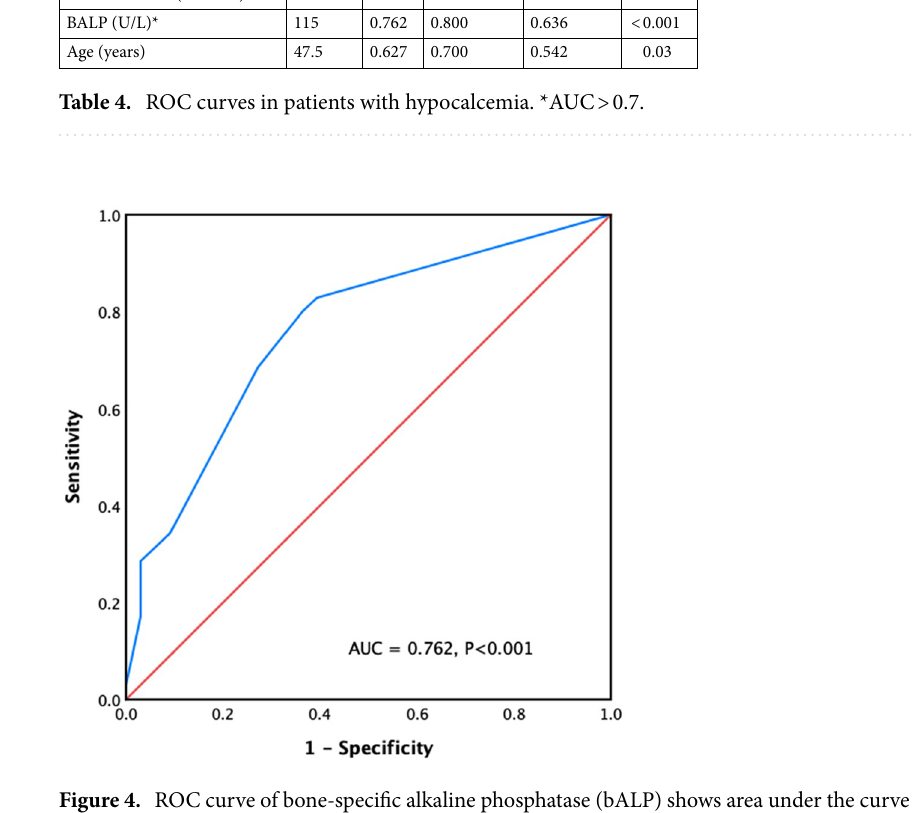
Figure 4. ROC curve of bone-specific alkaline phosphatase (bALP) shows area under the curve of 0.762, sensitivity of 80% and specificity of 63.6% using bALP cutoff point as 115